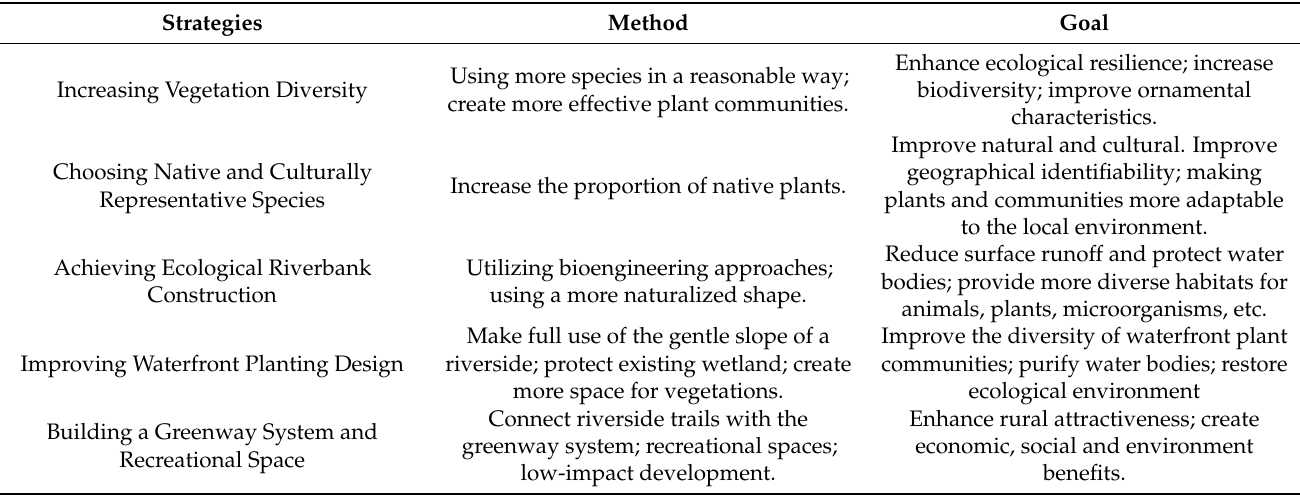
Table 8. Summary of optimization strategies (source: